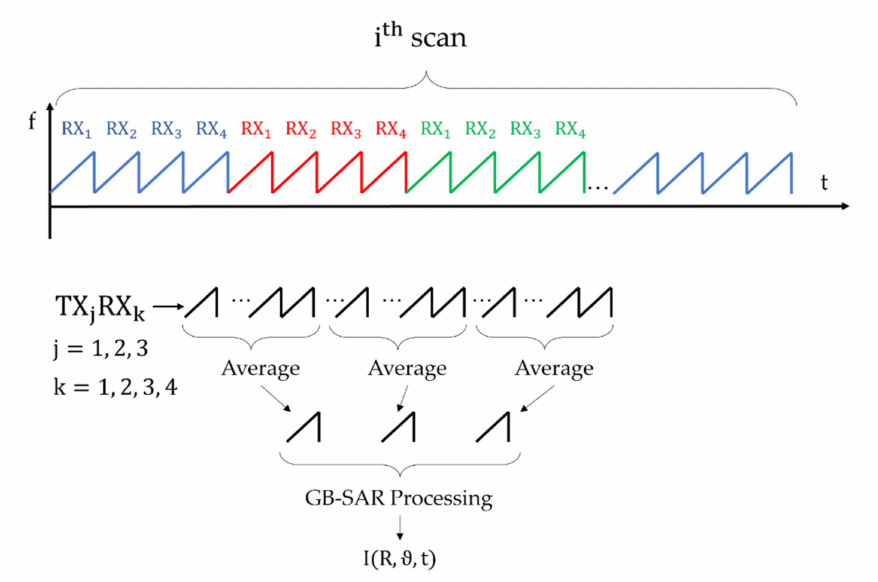
Figure 7. Data analysis